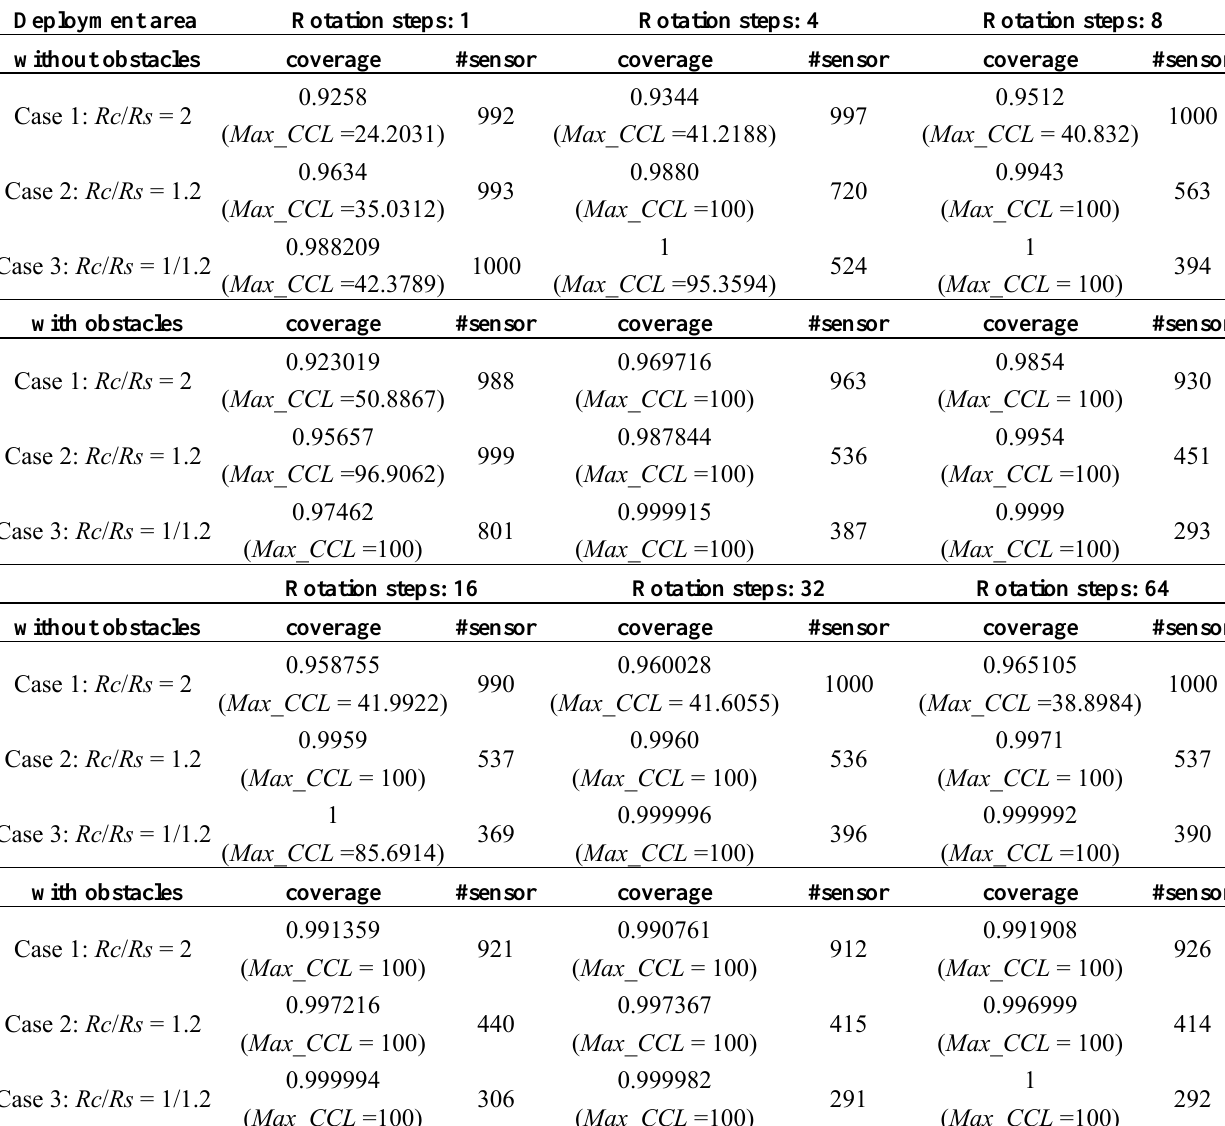
Table 7. The maximum sensing coverage rates and the usage of sensor nodes in Simulation